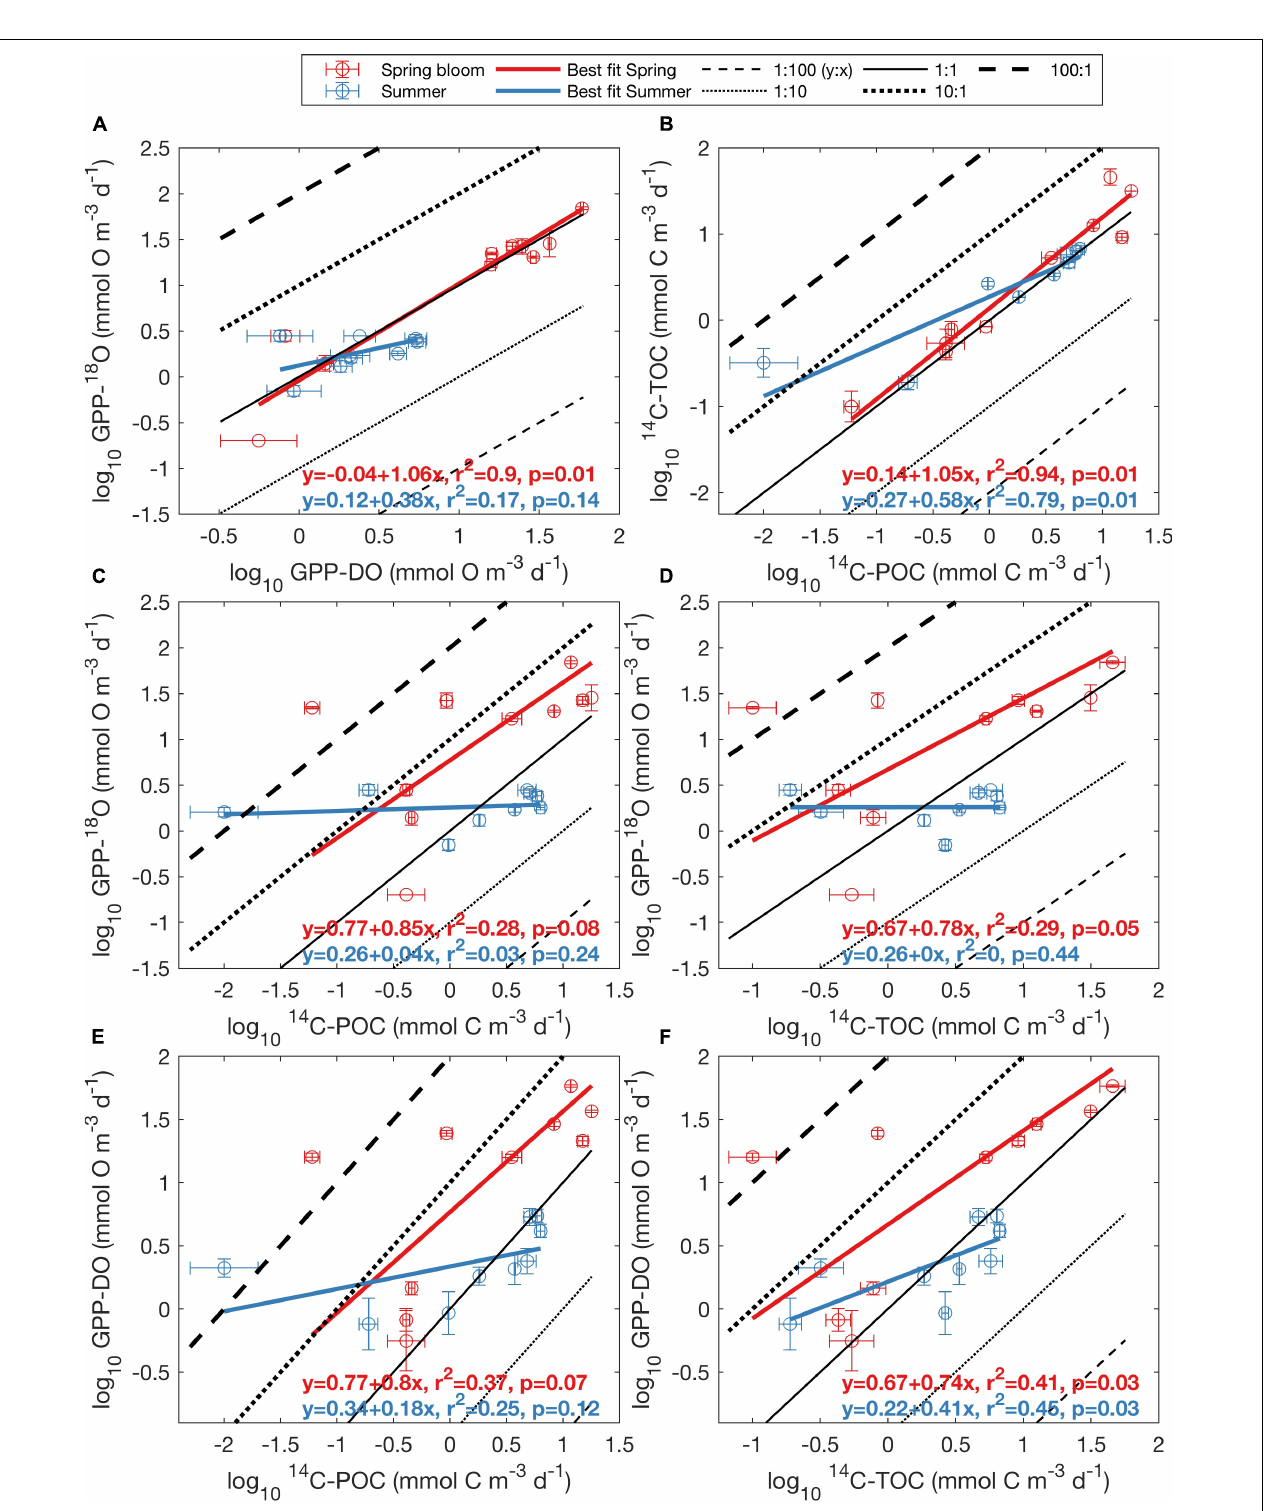
FIGURE 5 | Log-log relationship between oxygen- and carbon-based methods for May (red dots) and August (blue dots), presented as average ± standard error for each depth ( Figure 2 ). (A) GPP-1 18 O vs. GPP-DO, (B) 14 C-TOC vs. 14 C-POC, (C) GPP- 18 O vs. 14 C-POC, (D) GPP- 18 O vs. 14 C-TOC, (E) GPP-DO vs. 14 C-POC, and (F) GPP-DO vs. 14 C-TOC. All rates are volumetric in units of mmol O m − 3 d − 1 for oxygen and mmol C m − 3 d − 1 for carbon. Black lines represent ratios of y to x ranging from 1:100 to 100:1, with the solid line indicating a 1:1 relationship. The bold teal line represents the best linear fit to the aggregate dataset (i.e., including both seasons), while the orange line, if present, represents the best fit line calculated by Regaudie-de-Gioux et al. (2014), based on a global synthesis of PP observations.